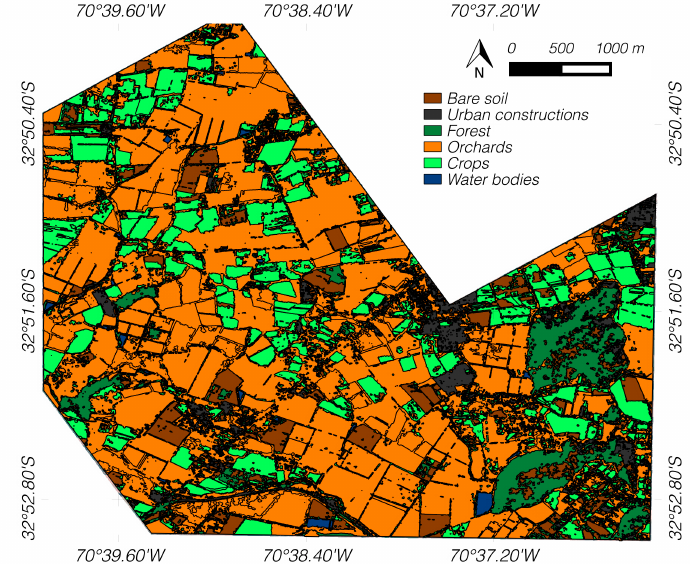
Figure 9. Final map generated with the disambiguation of T